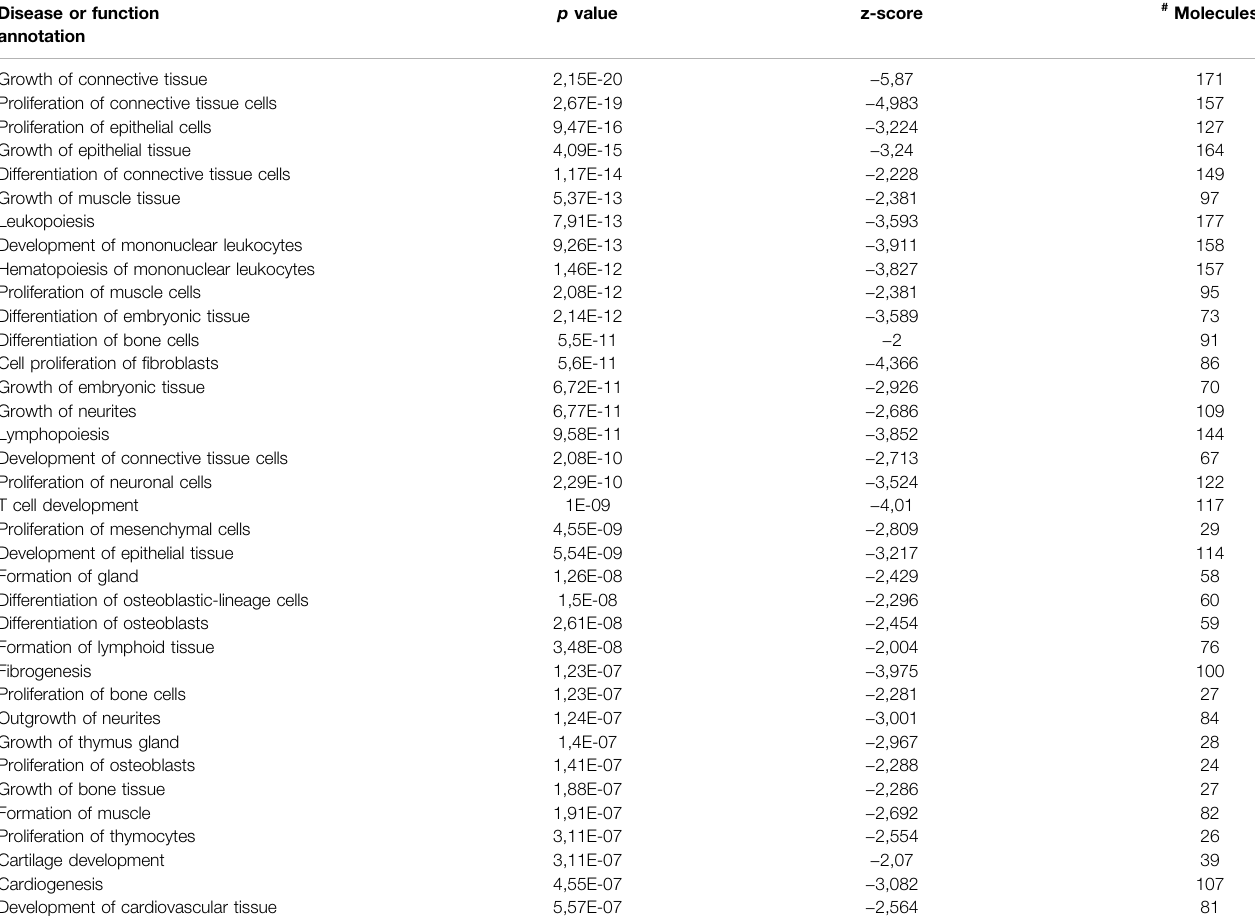
TABLE 2 | Disease or function annotations signi fi cantly altered in the “ tissue development ” category. Disease or function